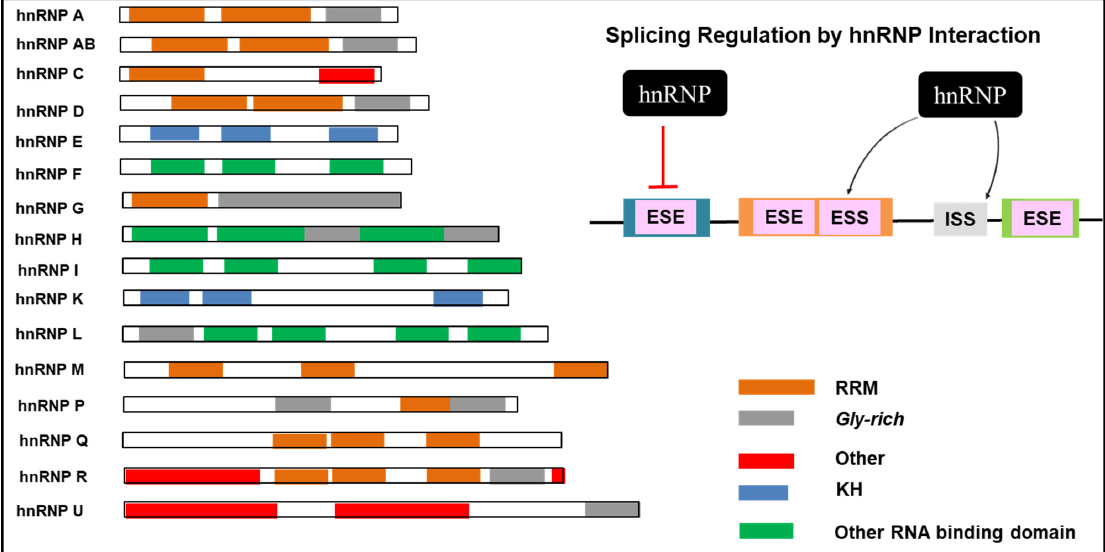
Figure 5. Alternative splicing regulation and the structural domains of hnRNP family. The domain structure of the hnRNP showing the RRM (RNA recognition motif), KH (K homology domain), and other RNA binding domain that is structurally different from RRM. hnRNP negatively regulates this process by binding to either exonic splicing silencers (ESSs) or intronic splicing silencers (ISSs). In addition, hnRNP blocks the activity of exonic splicing enhancers (ESEs) by binding to it [34,65,80].